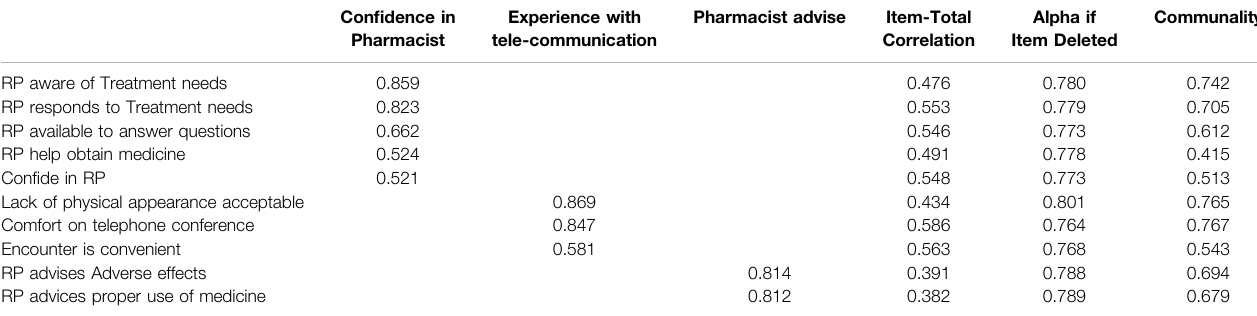
Extraction Method: Principal Component Analysis. Rotation Method: Varimax with Kaiser Normalization.